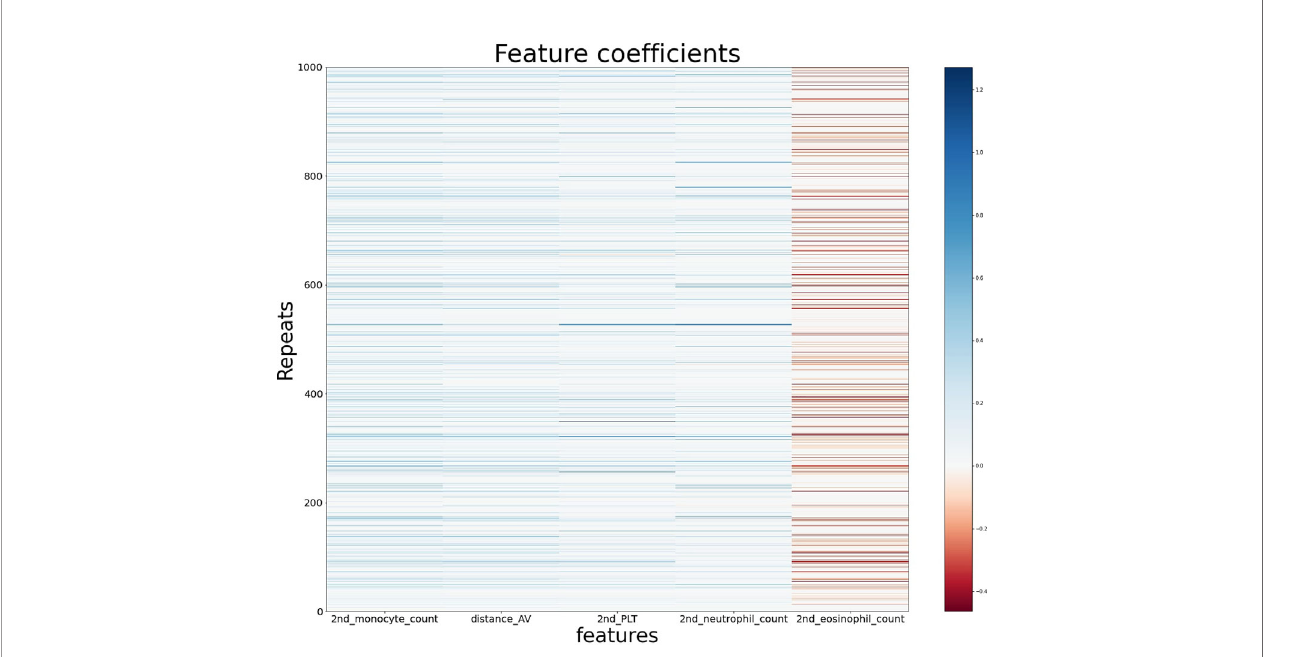
FIGURE 3 | The feature coef fi cients of the fi ve most important blood features in the ridge regression models using early-CRT for 1,000